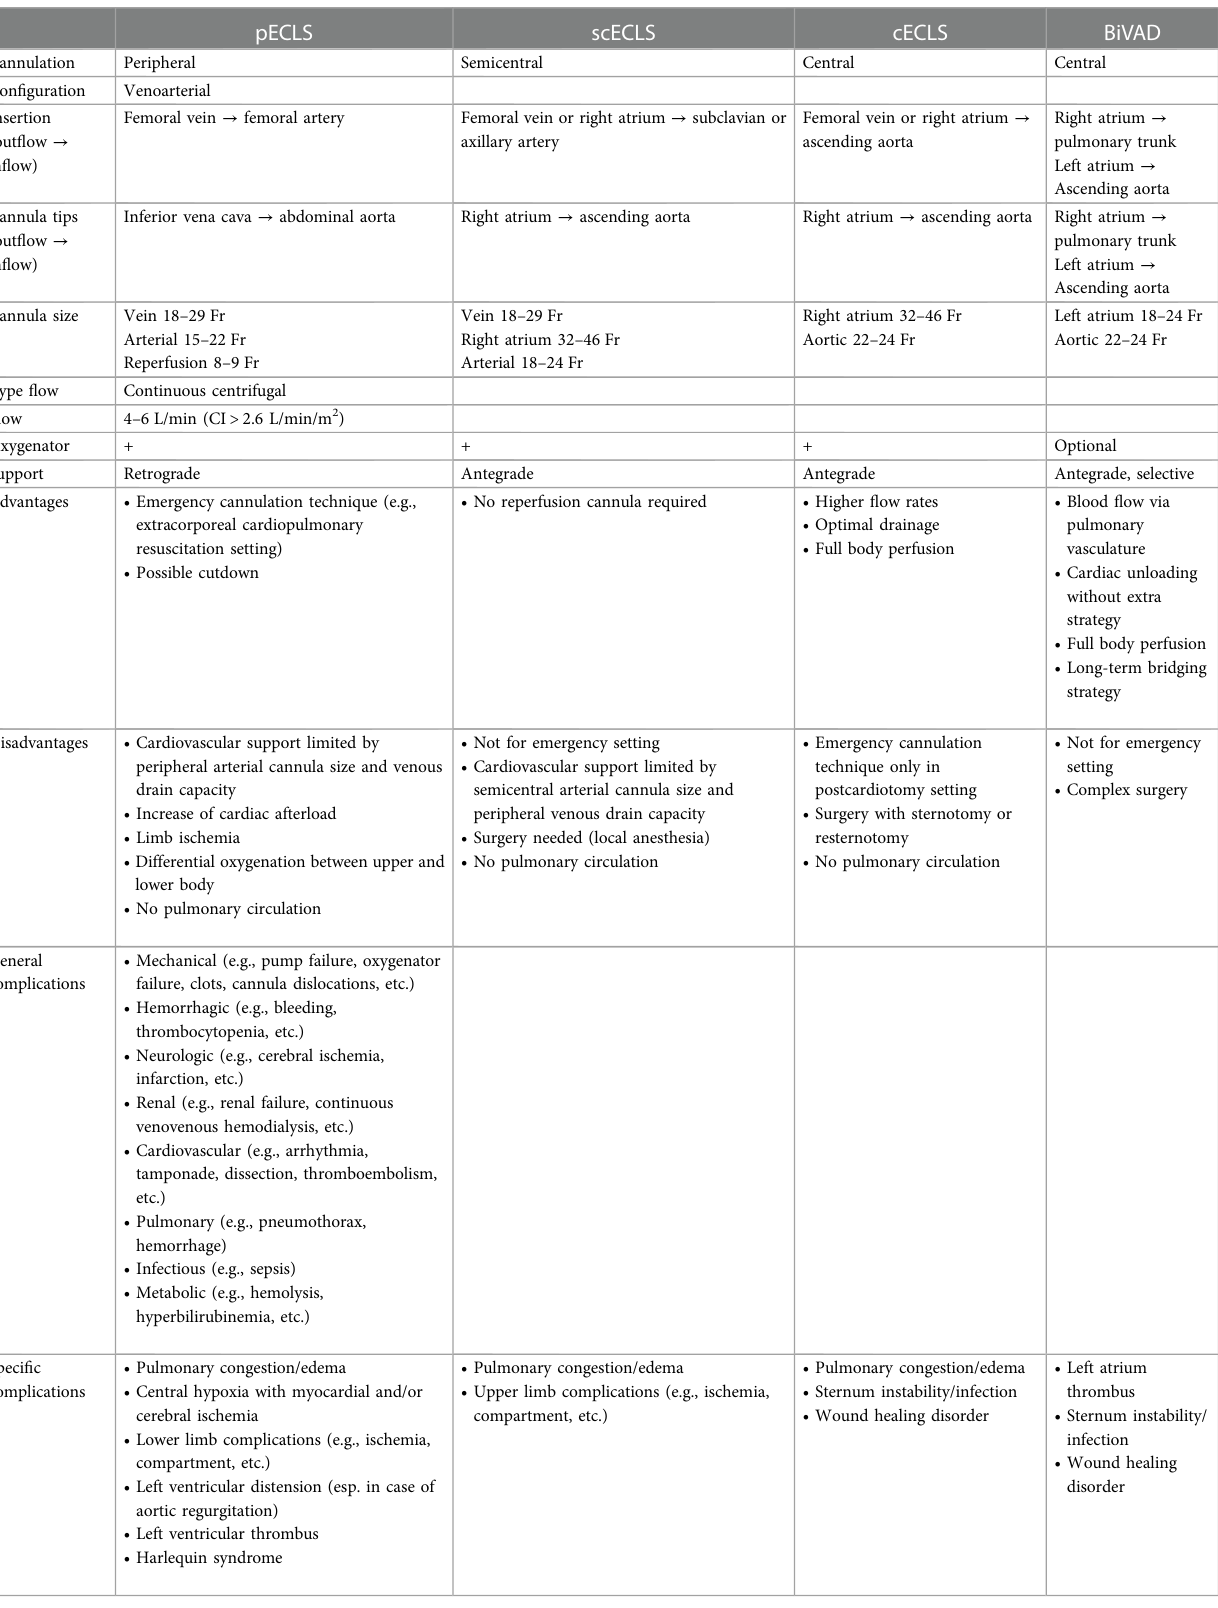
TABLE 1 Different interventional and surgical techniques for ECLS in